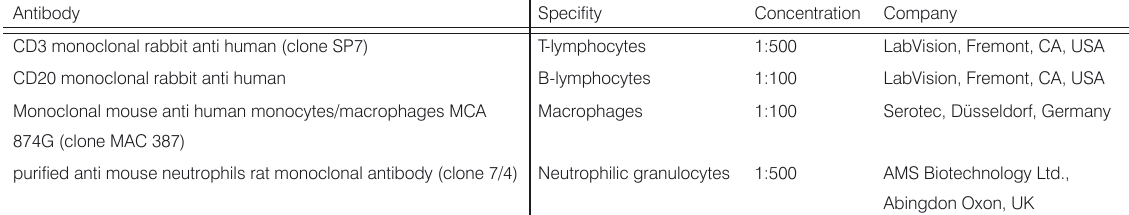
Table 1. Primary